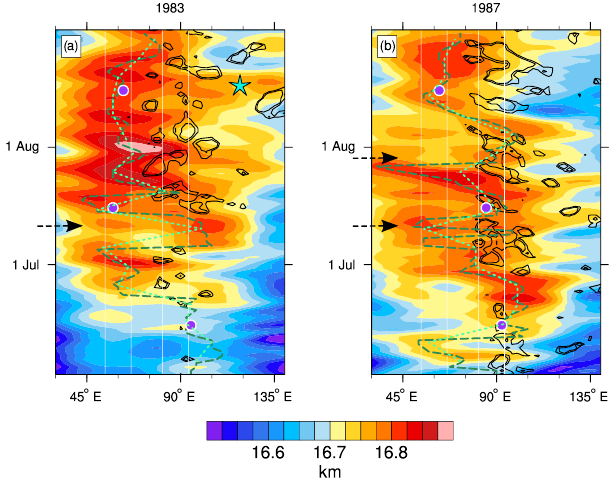
Figure 8. Hovmöller plots of geopotential height at 100hPa (aver- aged over 20–40 ◦ N) in km from ERA-I in summer (JJA) (a) 1983 and (b) 1987. Black contours show OLR (averaged over 15– 30 ◦ N) from NOAA at levels of 180Wm − 2 (inner contours) and 190Wm − 2 . Dashed dark green and light green show the movement of the SAH centre based on daily and pentad data. Purple dots show the location of the SAH based on monthly data. White lines indi- cate the IM (left) and TM (right) region. Arrows indicate splitting events discussed in the text. Turquoise star shows the strong shed- ding event in August 1983.